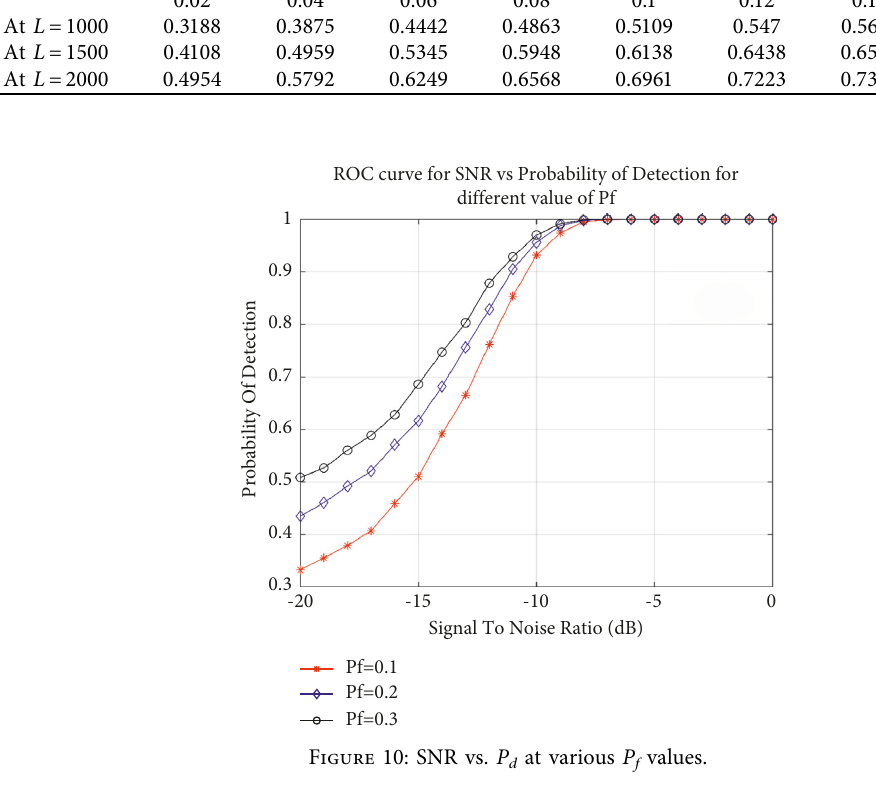
Table 5: P f vs. P d for the energy detector with the entropy method at different sample values.